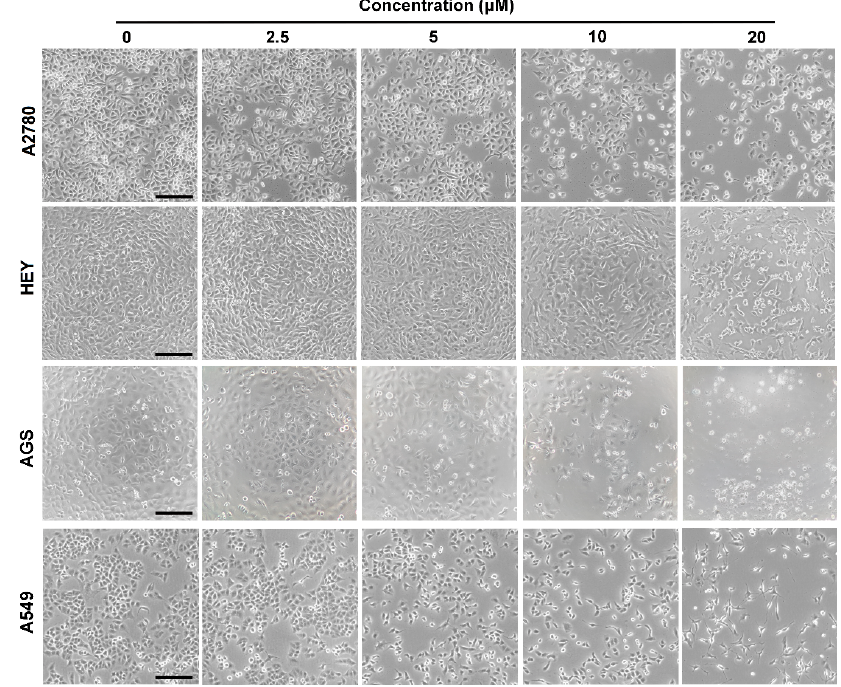
Figure 3. Morphology changes of A2780, HEY, AGS and A549 cells after treated with series concentrations of compound 1 (2.5 to 20 µM). Bar: 200 µm. Table 3. Viability of A2780, HEY, AGS and A549 cells after treated with the twelve compounds (20 µM). Cells were treated with 20 µM of the twelve compounds for 48 h and the cell viability was detected by MTT assay.